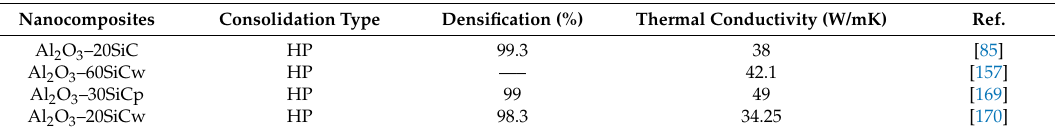
Table 3. Thermal conductivity of Al 2 O 3 –SiC